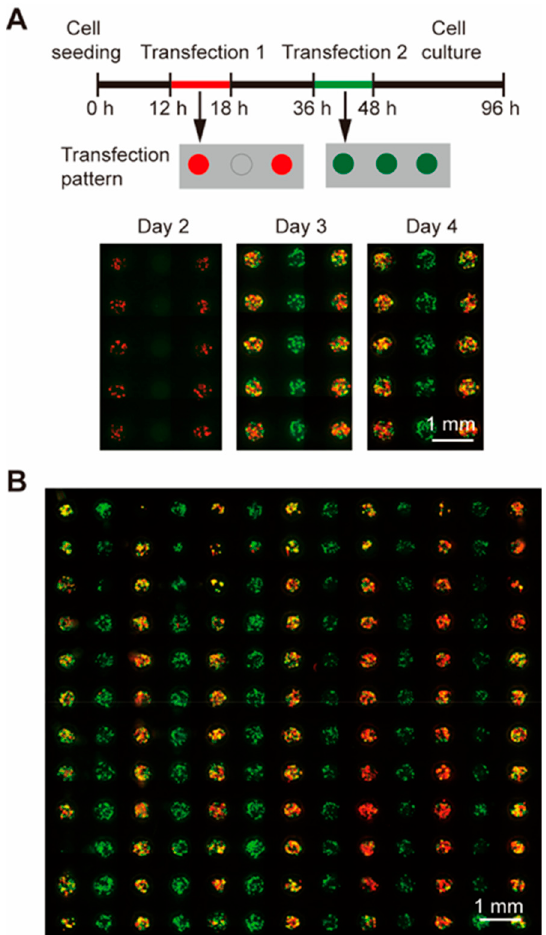
Figure 3. Sequential transfections of different plasmids encoding GFP and RFP into 293T cells on the SMAR-chip. ( A ) The transfection protocol is illustrated in the upper panel. RFP was transfected into the cells in alternate lines 12 h after cell seeding, and GFP was transfected to all the cells 18 h after the RFP transfection. Fluorescent images shown in the lower panel were taken sequentially at day 2, 3, and 4. ( B ) Merged fluorescent micrograph of 293T cells sequentially transfected with green and red fluorescent proteins. (scale bars, 1 mm).